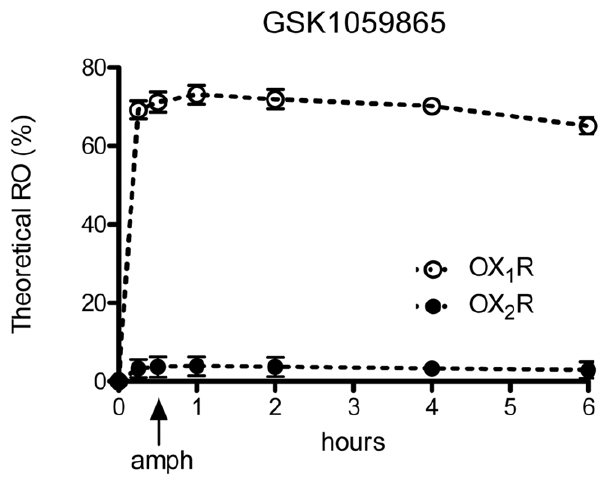
Figure 1. Brain receptor occupancy of GSK1059865. Theoretical brain receptor occupancy for GSK1059865 after intraperitoneal administration of 30 mg/kg to male SD rats. Data points represent mean + / 2 standard